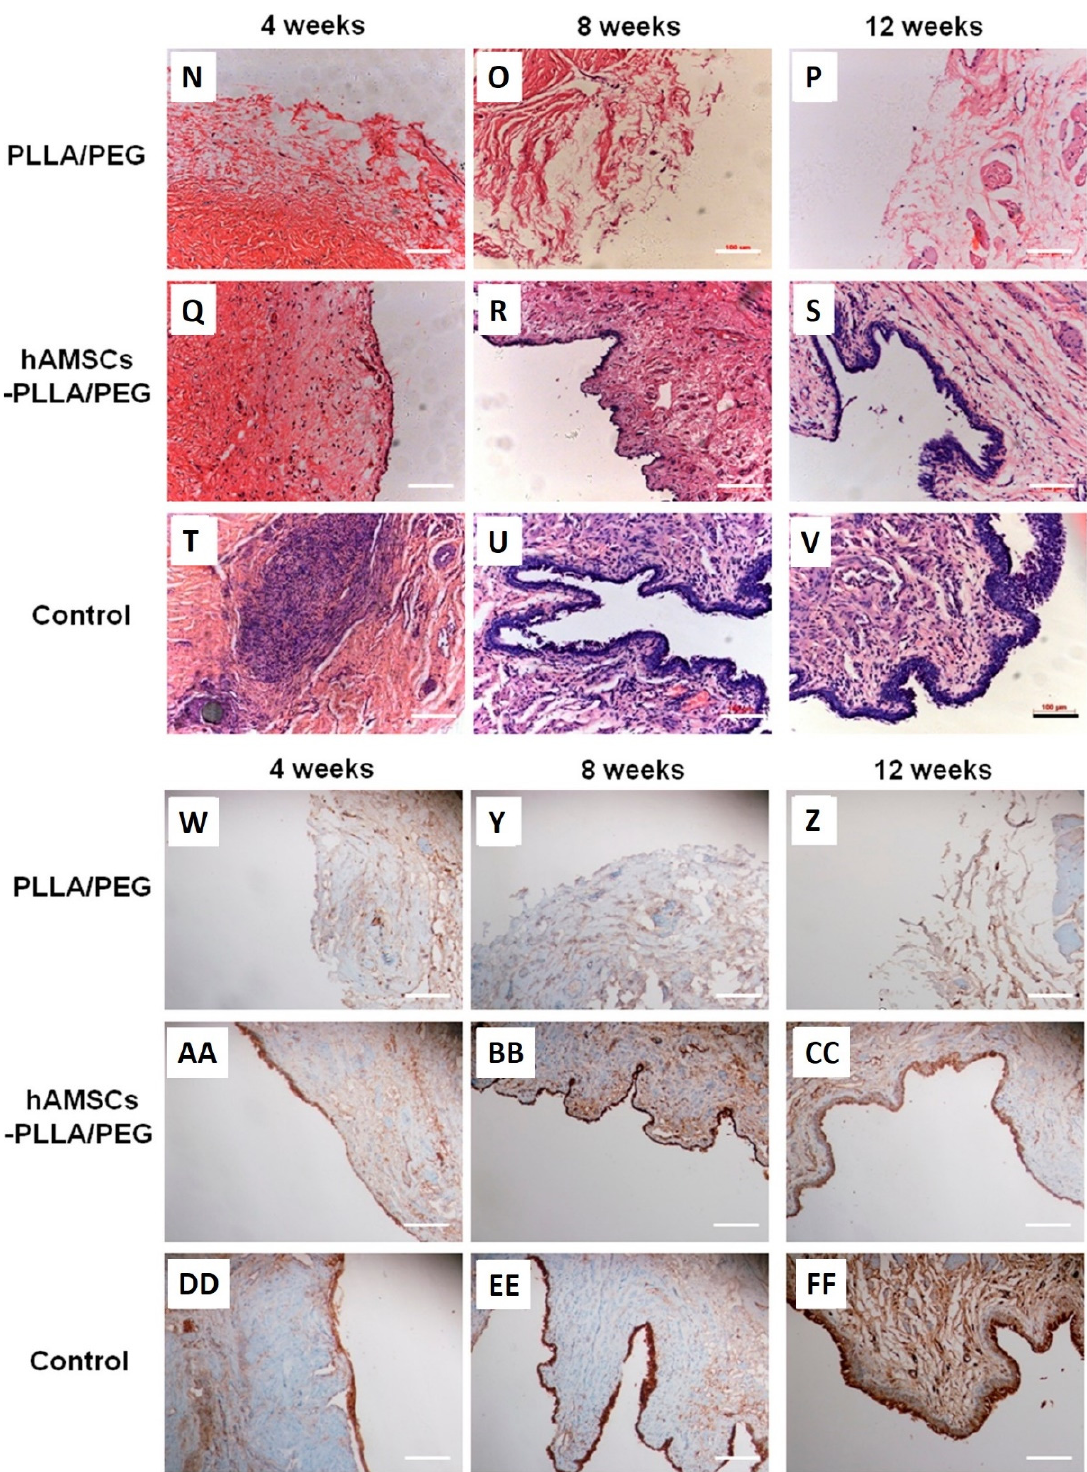
Figure 9. ( N – V ) show the H & E staining images of animals treated with different scaffolds at weeks 4, 8, and 12. ( W – FF ) show the IHC staining images of urethra tissues against the AE1/AE3 marker at weeks 4, 8, and 12. Adopted from reference [219]. Scale bars, 100 μ m. EVs derived from stem cells can recapitulate the same regenerative responses observed in whole cell-based therapies. Exosomes are a subclass of EVs that are sized between 30 and 120 nm [220]. Wang et al. blended poly (L-lactide-co-caprolactone) (P(LLA-CL)) with collagen to produce a delivery platform for ASC-derived exosomes [221]. The developed system was not toxic against fibroblast cells and reduced the secretion of pro- inflammatory factors such as IL-6. In vivo study showed that the exosome-nanofibrous scaffold system prevented US and induced a multilayer epithelial tissue formation. Alt- hough EVs are an integral part of cells niches and their healing potential has been shown